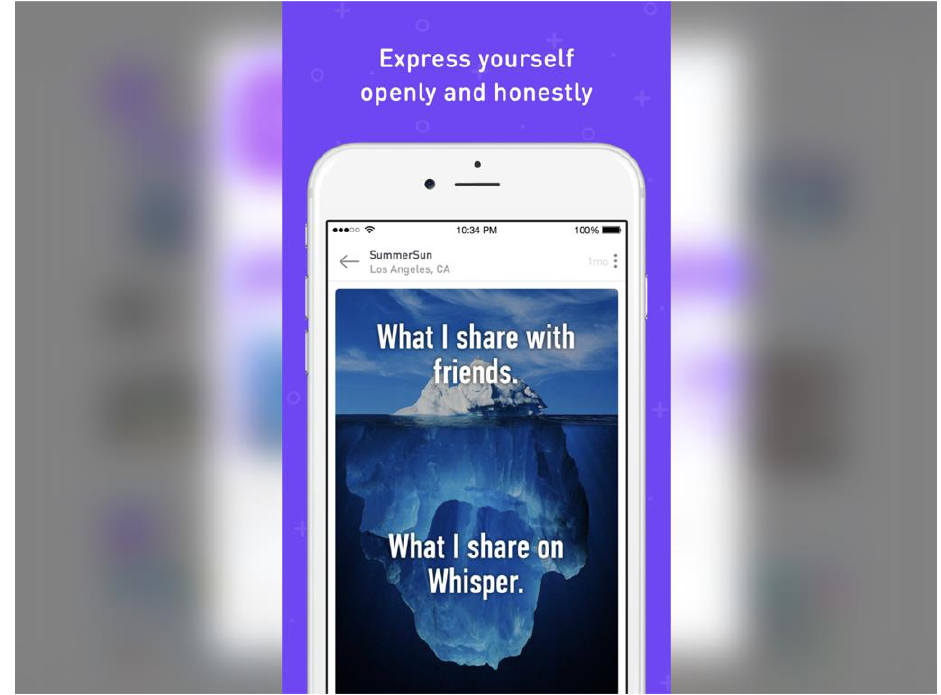
Figure 4. A screenshot from the Whisper iOS App Store listing, 26 September 2016 [84].